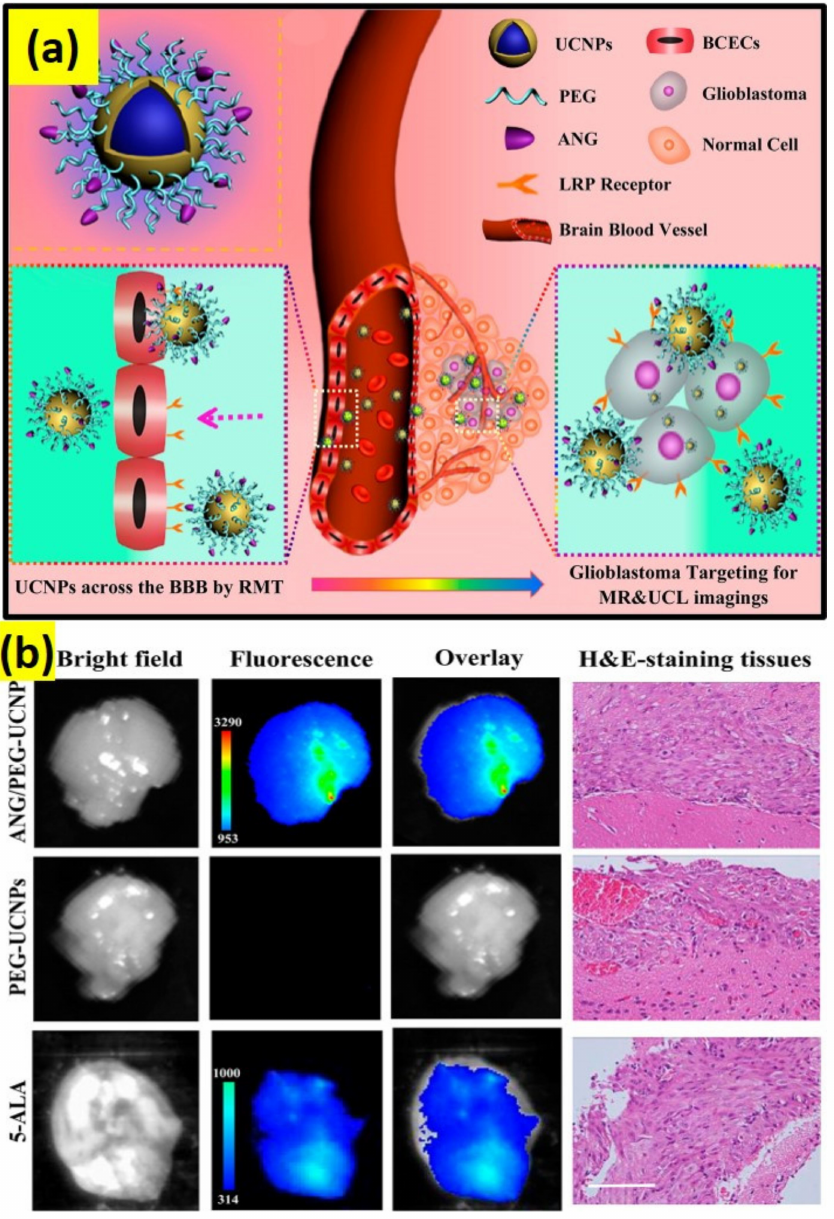
Figure 2. ( a ) ANG/PEG-UCNPs: a dual mode targeting system for BBB crossing and targeting the glioblastoma. ( b ) Glioblastoma-bearing brain images after 1 h of intravenous injection with 5-ALA (excitation, 470 nm; emission, 650 nm) and ANG/PEG-UCNPs, PEG-UCNPs (excitation, 980 nm; emission, 800 nm); scale bar: 100 µ m